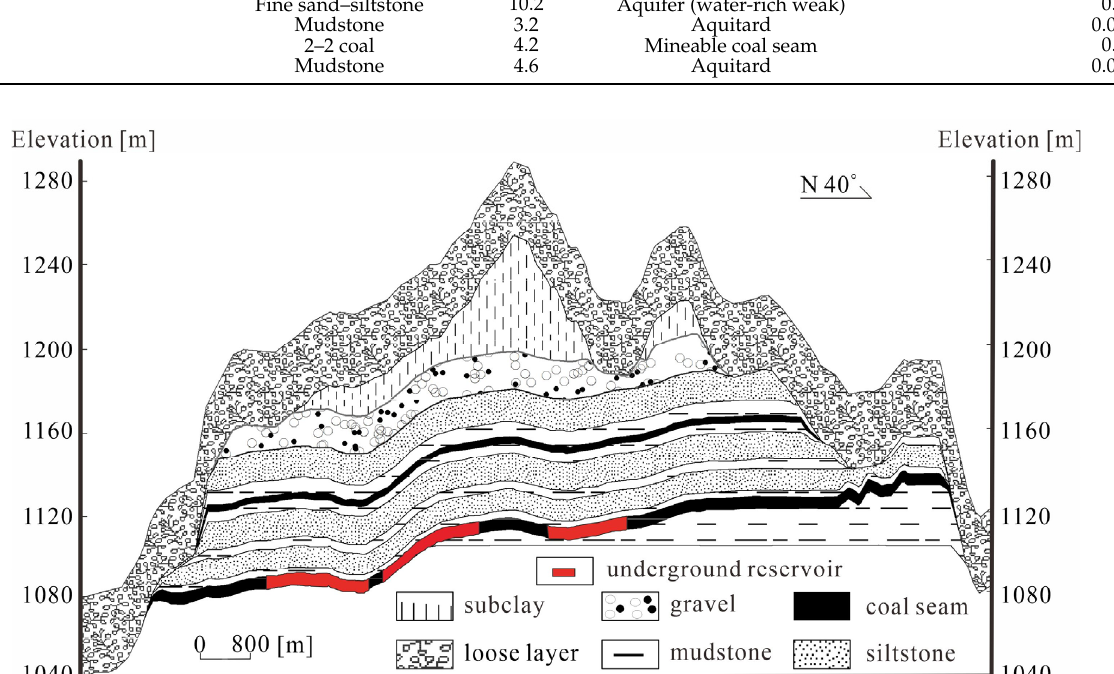
Figure 2. AA’ stratigraphic section